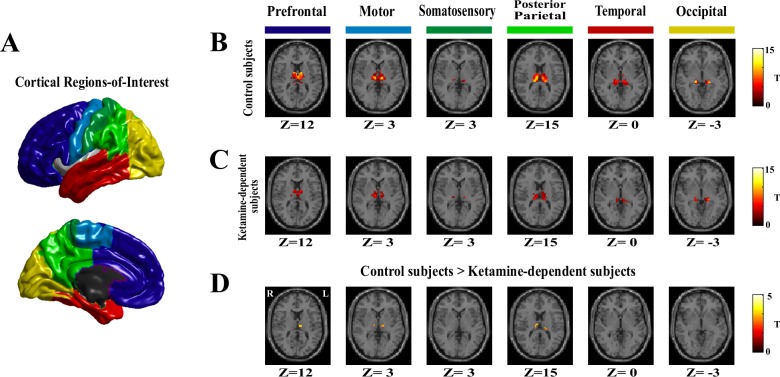
The diffusively decreased thalamocortical connectivity in ketamine-dependent subjects.A. The 6 cortical regions-of-interest. B. Thalamocortical connectivity of the drug-free control subjects. C. Thalamocortical connectivity of the ketamine-dependent subjects. D. Group differences in thalamocortical connectivity for the drug-free control subjects and the ketamine-dependent subjects. All shown clusters in this study were corrected for multiple comparisons with the corrected statistical threshold of P<0.05 using the AlphaSim program (single voxele p value<0.01, and ≥108 mm3 (4 adjacent voxels). A presentation formation referred to the previous study [26].